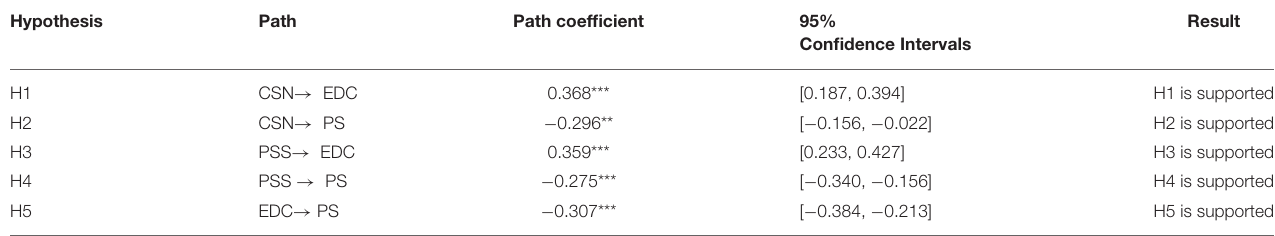
TABLE 4 | Verification table of path coefficient.